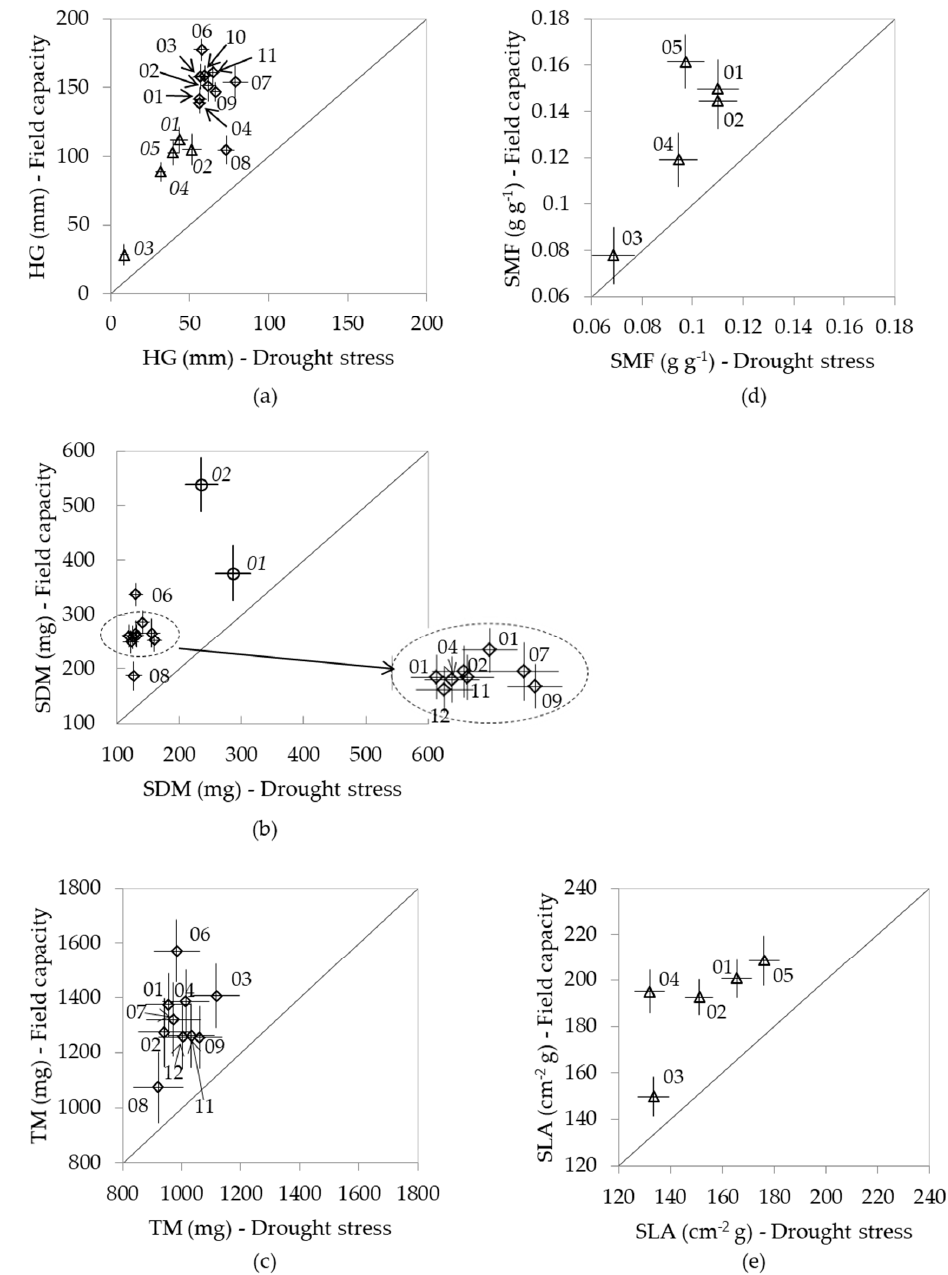
Figure 3. Analysis of plasticity by species for growth variables and biomass components with significant response to watering treatment in ( a ) HG : height growth increment; ( b ) SDM : stem dry mass; ( c ) TDM : total dry mass; ( d ) SMF : stem mass fraction; and ( e ) SLA : specific leaf area ( P. oocarpa = ○ , P. patula = ◊ and P. pseudostrobus = Δ ). Bars indicate the standard errors in the two treatments.